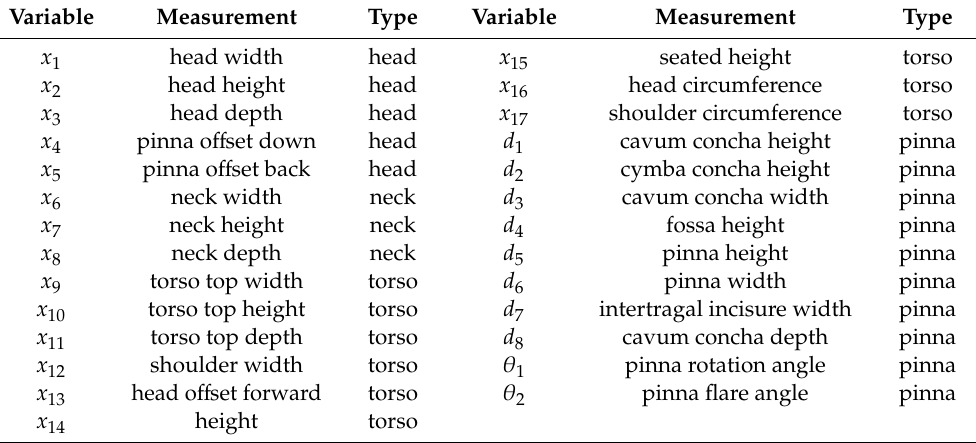
Table 1. Definition of anthropometric parameters in the CIPIC database